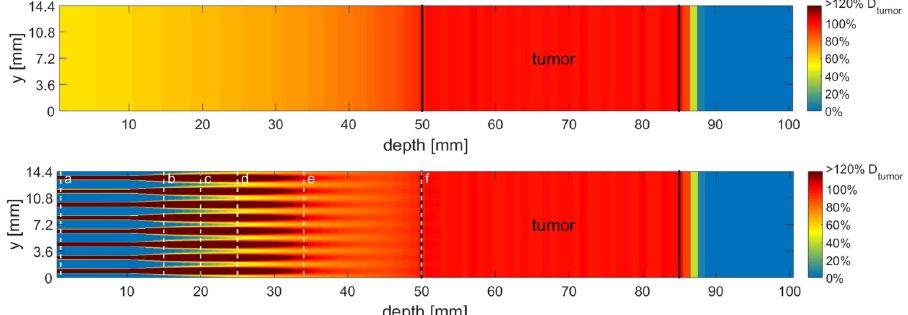
Fig 1. A side cut of the calculated dose distribution of a conventional proton irradiation and a proton minibeam irradiation for a tumor in 5–8.5 cm depth. The mean dose for both scenarios is the same in every depth, however, the distribution of the dose varies strongly. The dose is color-coded with a cut-off at 120% of the desired tumor dose D tumor . The black lines indicate the beginning and the end of the tumor. The dashed white lines labeled with a–f show the location where calculated minibeam sizes are the same as in the experimental setup with ~95, 199, 306, 411, 561 and 883 μ m,